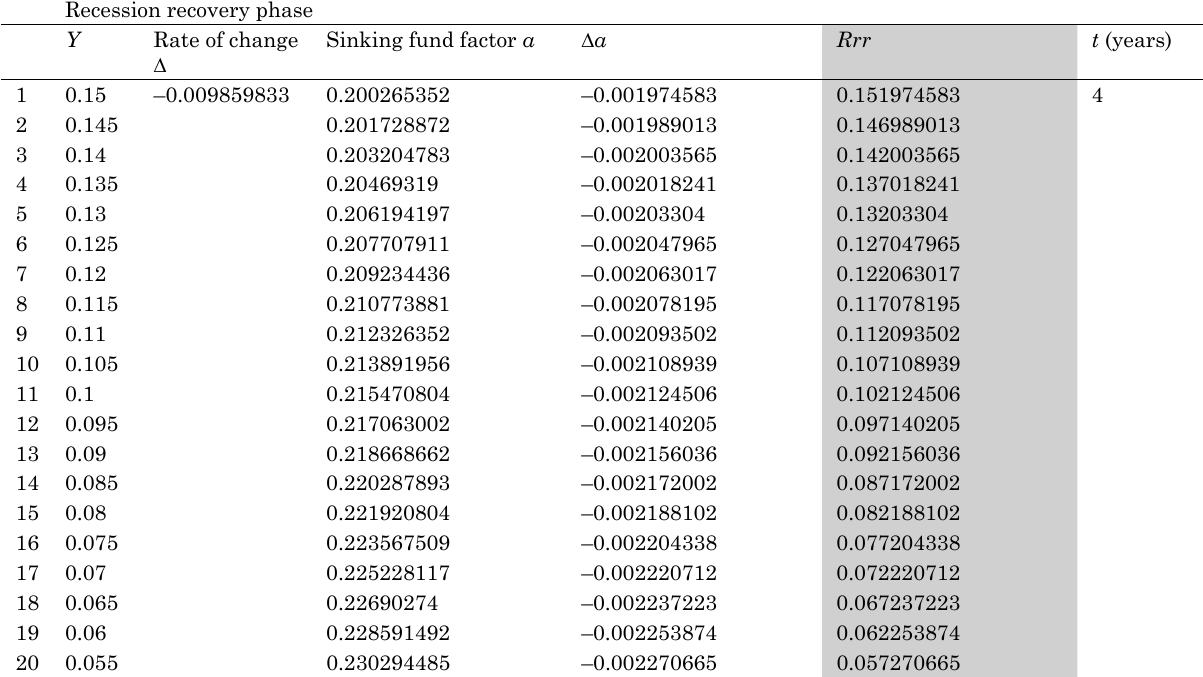
table 4. calculation of overall cap rate in the recovery recession (–) phase recession recovery